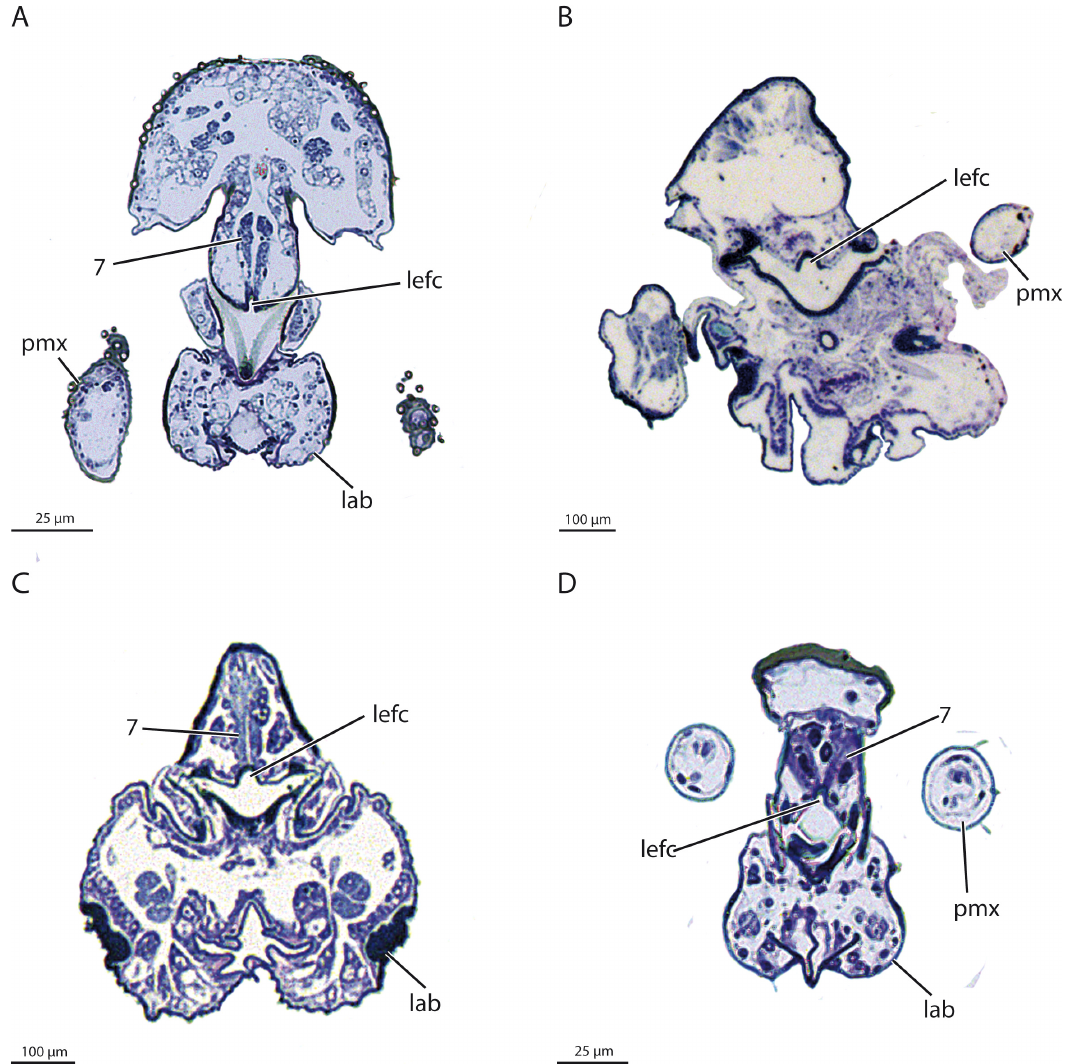
Figure 9 . Cross-sections. A, Psychoda alternata (Psychodidae). B, Tipula paludosa (Tipulidae). C, Trichocera saltator (Trichoceridae). D, Corethrella appendiculata (Corethrellidae). Abbreviations: lab, labella; lefc, labroepipharyngeal food channel; pmx, maxillary palp; 7, M.